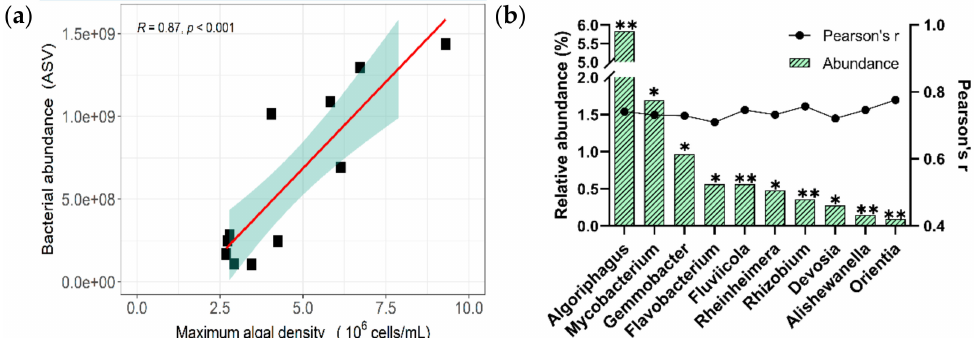
Figure 5. The relation of algae and bacteria in the systems. ( a ) Pearson correlation between N max of algae and absolute abundance of bacteria. ( b ) Typical bacteria that were positively related to algal growth. The star mark (*) means p < 0.05 and the double star mark (**) means p < 0.01. Figure 5b shows the genus that has a significantly correlated with algal density. Eleven genera were selected following the certain rules (Pearson’s r > 0.6, p < 0.05, and the relative